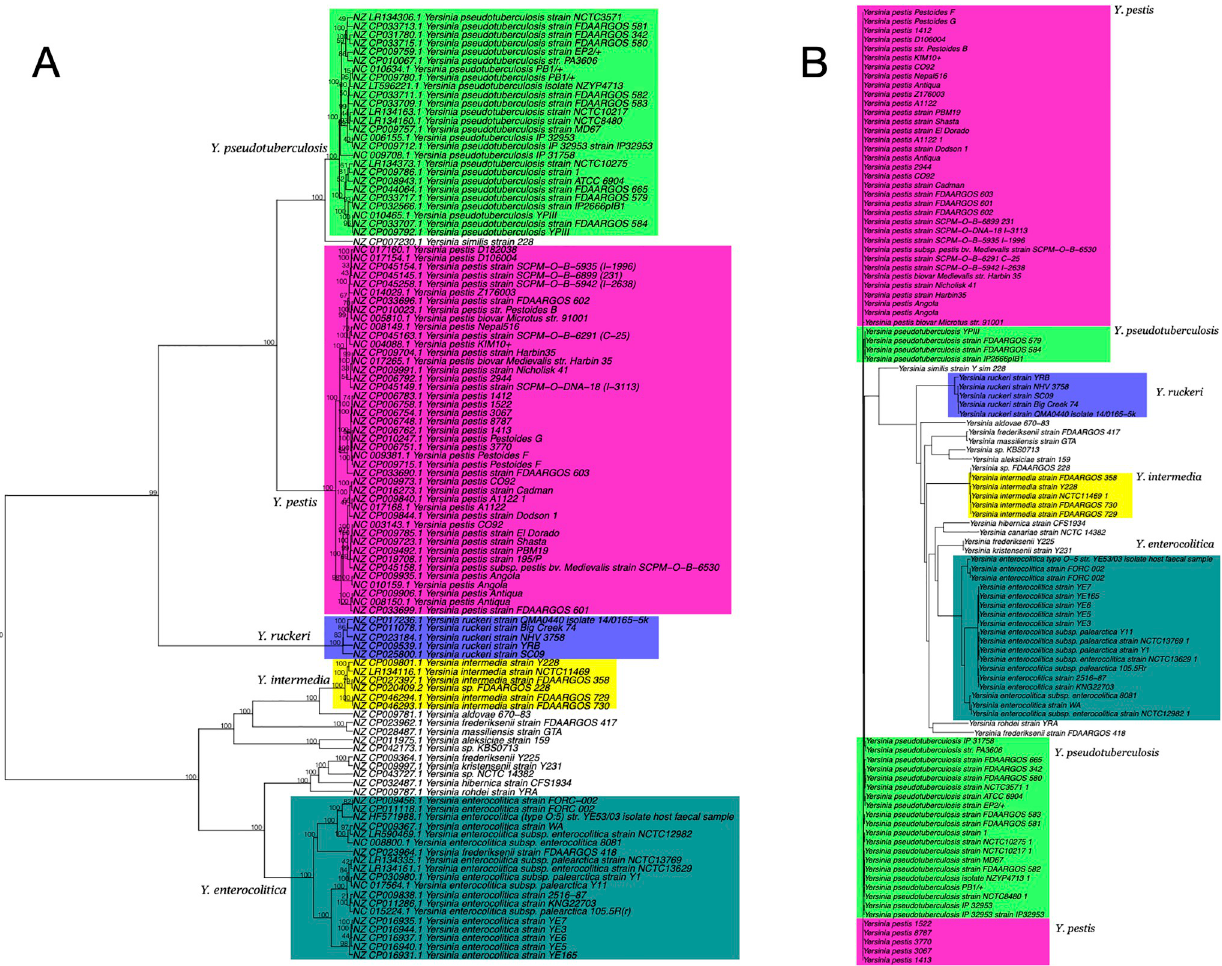
Fig 2. Phylogenetic trees of 110 Yersinia strains based on pentanucleotide frequencies (A) and MLST analysis (B). The trees were constructed using the Manhattan distance and Ward’s algorithm (A) or the neighbor-joining method (B). The numbers at the nodes indicate the percentage occurrences among 1,000 bootstrap values. Separated groups of species are